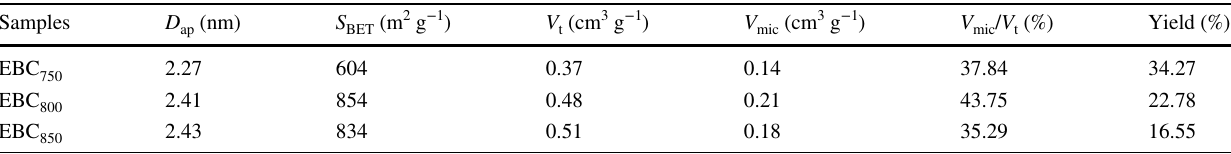
Fig. 2 a Nitrogen adsorption/desorption isotherms, b pore size distribution curves, c XRD patterns, d Raman spectra, e survey XPS spectra of EBCs, f high-resolution XPS spectrum at N 1s region of EBC 800 Table 1 Pore structure parameters and yields of